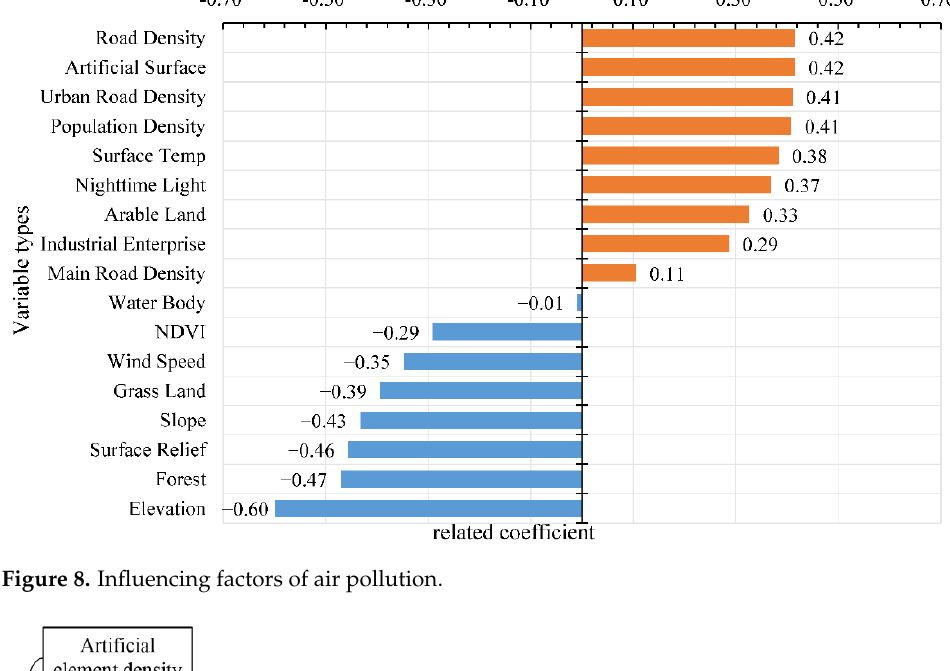
Figure 8. Influencing factors of air pollution.